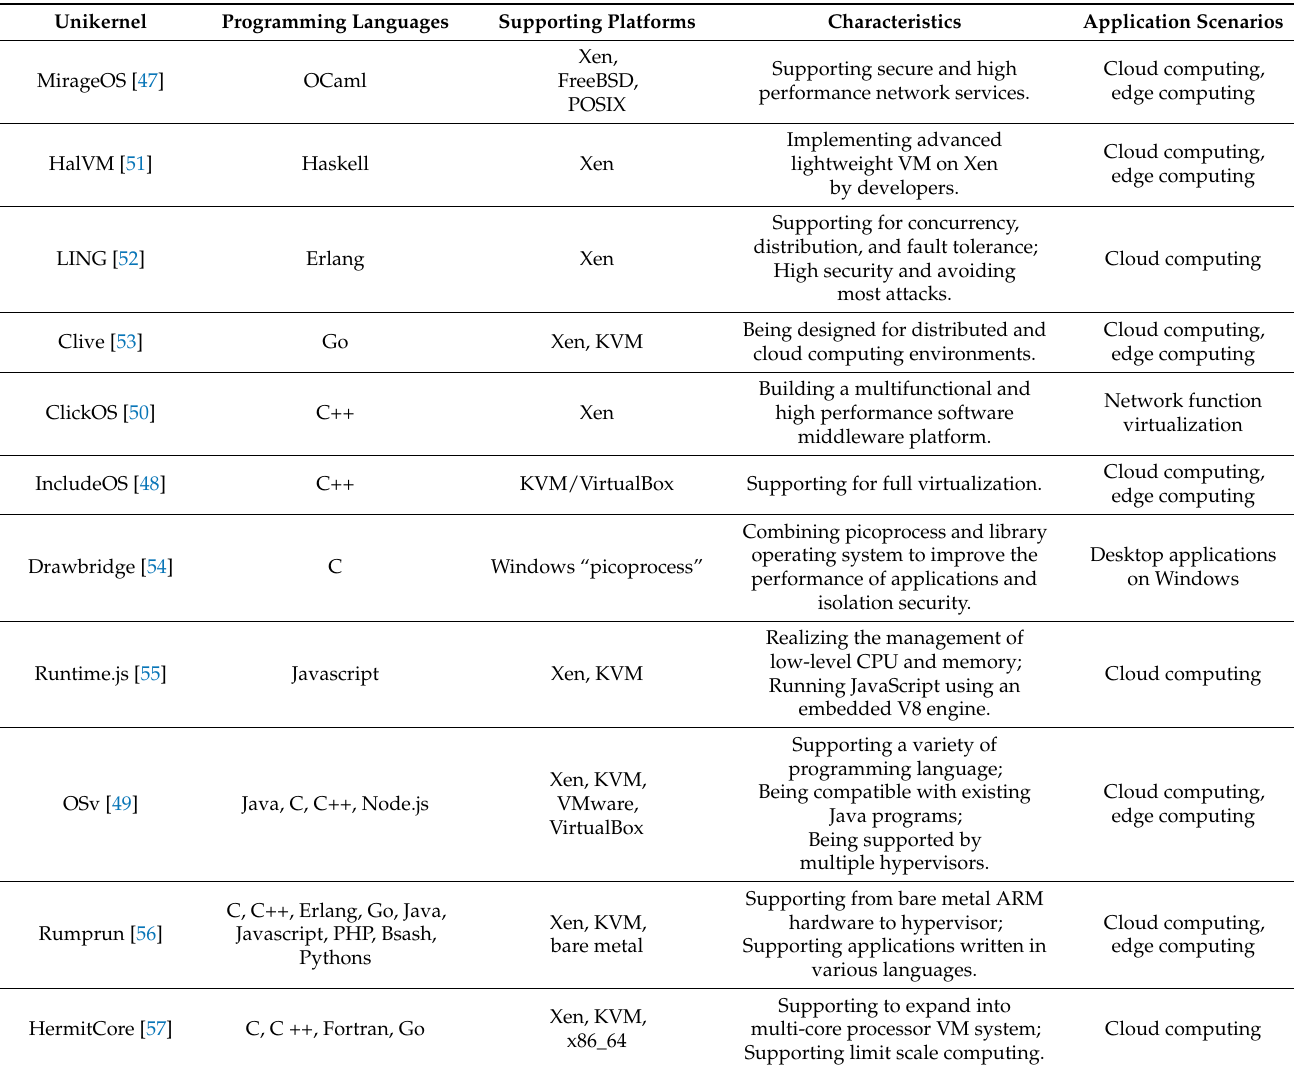
Table 3. Summary of different Unikernel based